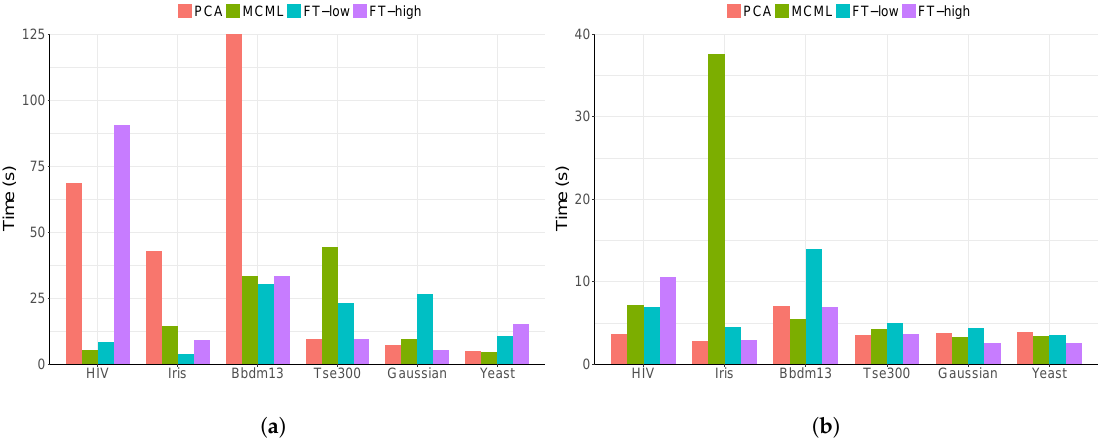
Figure 12. Time completion of participant 14 broken down by condition and dataset. ( a ) Cluster task; ( b ) Outlier